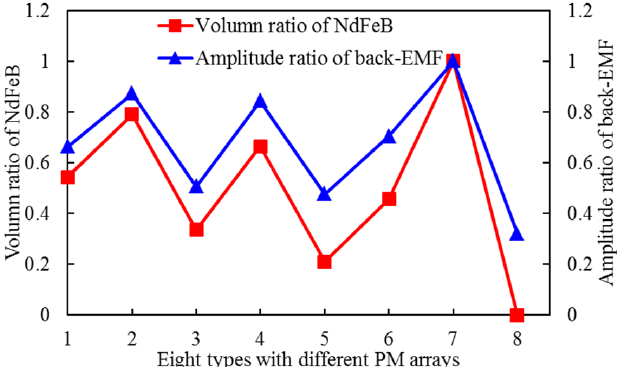
Figure 6. Ratios of NdFeB volume and back-EMF.